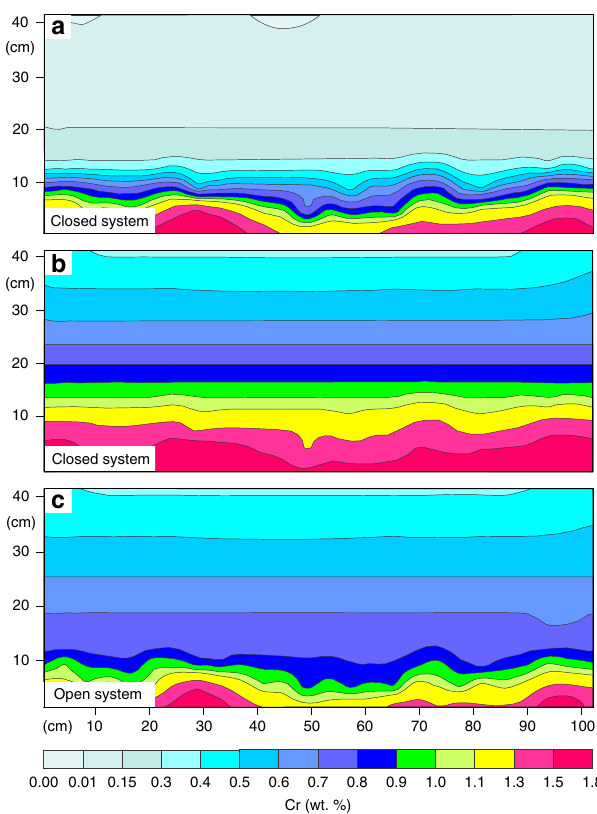
Fig. 6 Two-dimensional geochemical modelling of Cr in the Main Magnetite Layer. The two-dimensional modelling is based on the results shown in Fig. 3b and clearly illustrates the need for an open system to accurately describe the change in the Cr concentration ( D = 525) in the MML. In ( a ), a closed system is assumed and a relatively thin basal layer is chosen (40 m) to accurately reproduce the Cr concentration around the growth nodes. However, higher up in the pro fi le Cr is depleted much too rapidly compared with Fig. 3b. In ( b ), a thicker basal layer (130 m) more accurately reproduces the Cr concentration towards the top of the pro fi le but the Cr concentration around the growth nodes is far too high. Only in an open system c , in which the basal layer grows incrementally from initially 20 m to beyond 57 m thick due to frequent magma addition, can the Cr- concentration accurately be reproduced in two-dimensions ( “ Methods ” ). Because undulations observed in the solidi fi cation front in the chemical map (Fig. 3b) are not statistically signi fi cant after about 20 cm of crystallization, a planar solidi fi cation front is assumed above this point in our